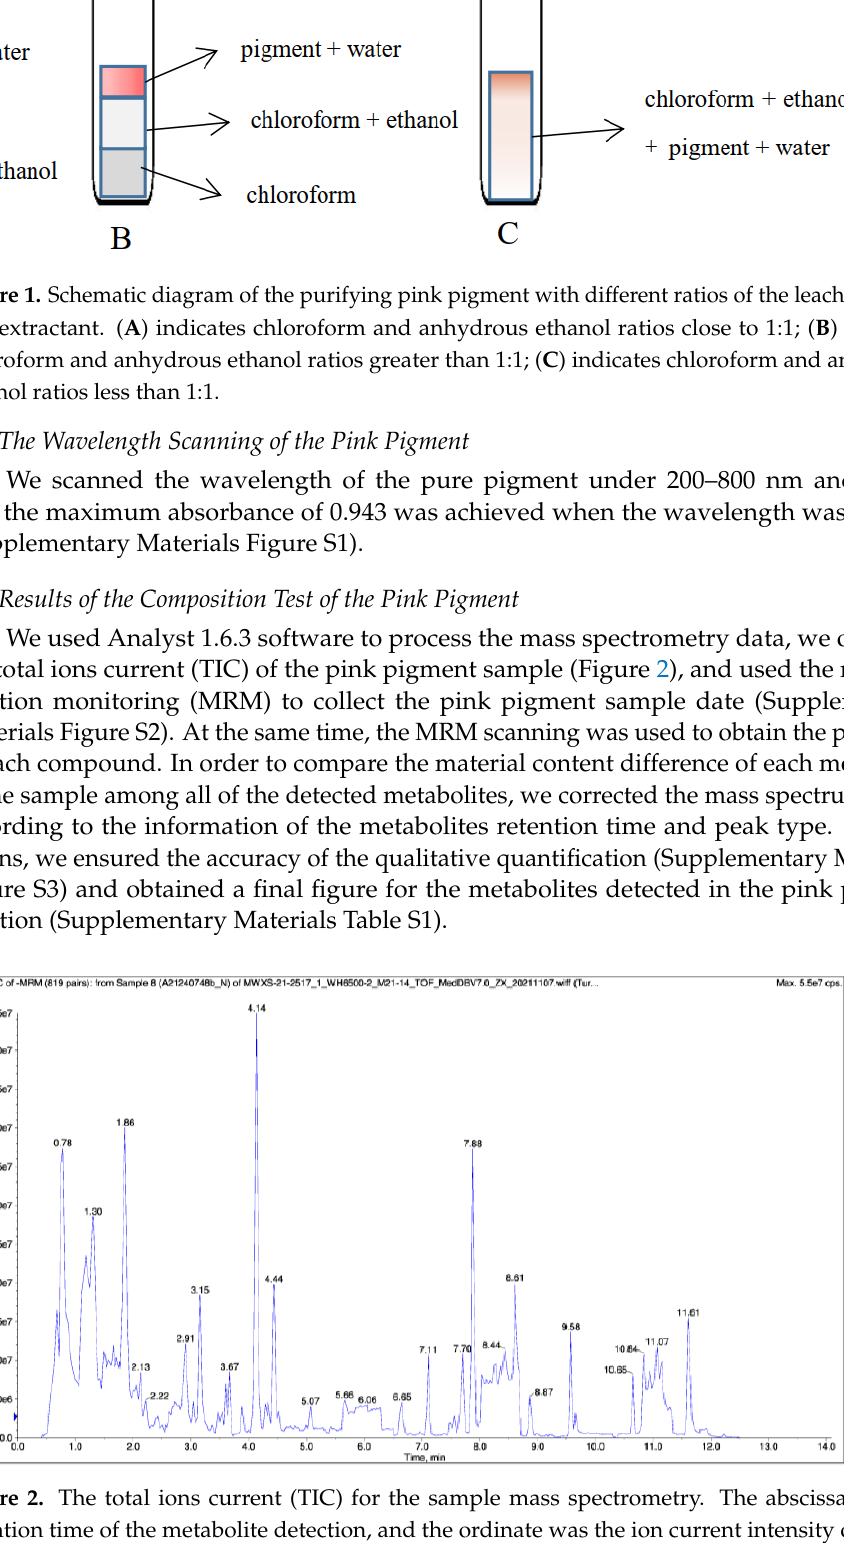
Table 3. Top ten compounds of the pink pigment.